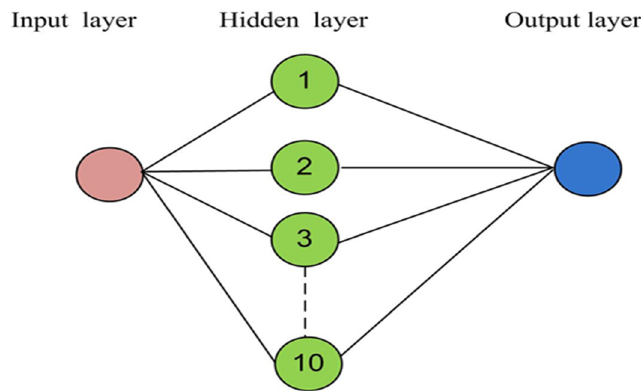
Figure 2. Schematic of ANN architecture for rectangular beams.